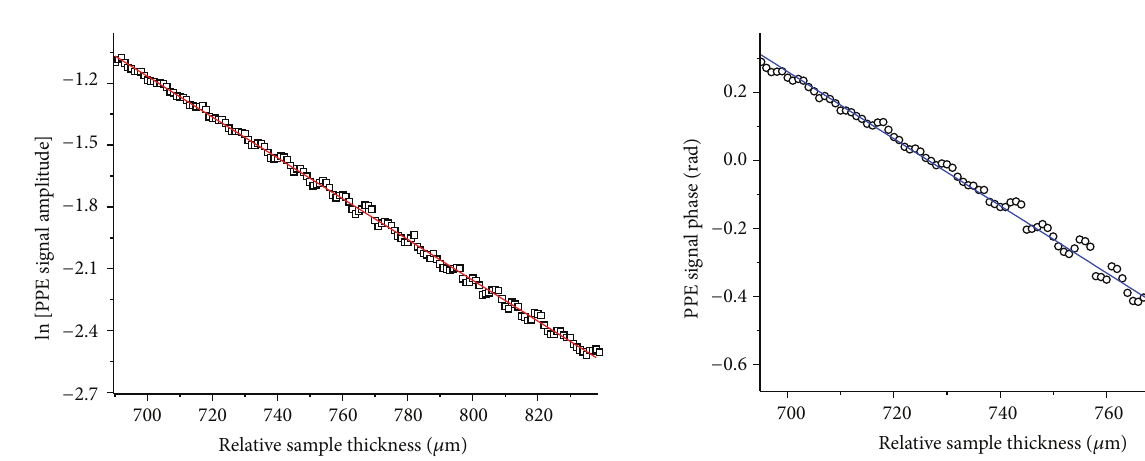
Figure 3: PPE signal phase as a function of the cavity length, having water as a sample and PVDF as PE detector; the solid line represents the best fitting of (2) to the experimental